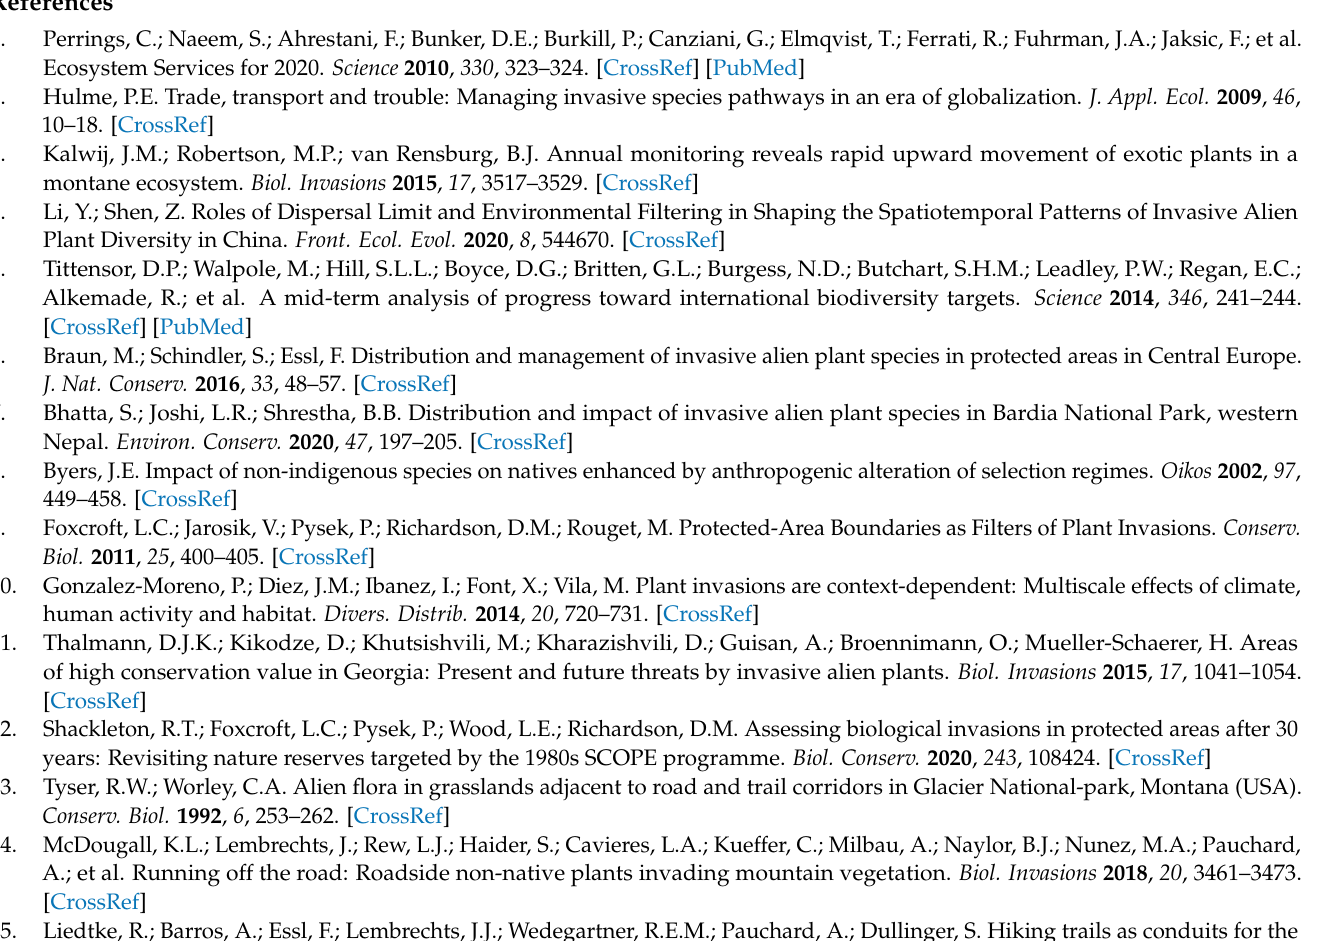
Table S1: The checklist of the alien invasive plants in Dayao Mountain National Nature Reserve, Table S2: Plots investigation of herbs in Dayao Mountain National Nature Reserve, Table S3: Linear mixed models constructed for native herbs, all invasive alien herbs, new and old invasive alien herbs richness and various environmental factors at the altitude gradient of the reserve, Table S4: Information on herbs species in plots of Dayao Mountain National Nature